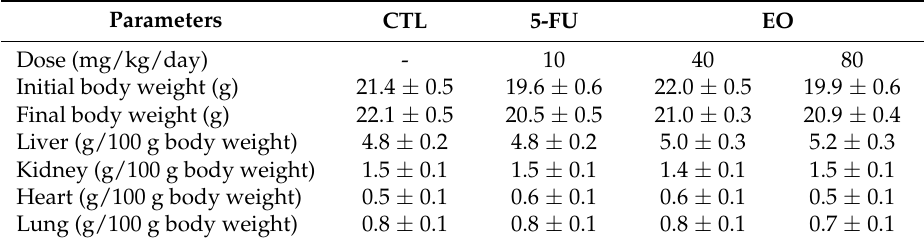
Table 3. Effect of the essential oil (EO) from the leaves of Croton matourensis on body and relative organ weight from C.B-17 SCID mice with HepG2 cell xenografts.